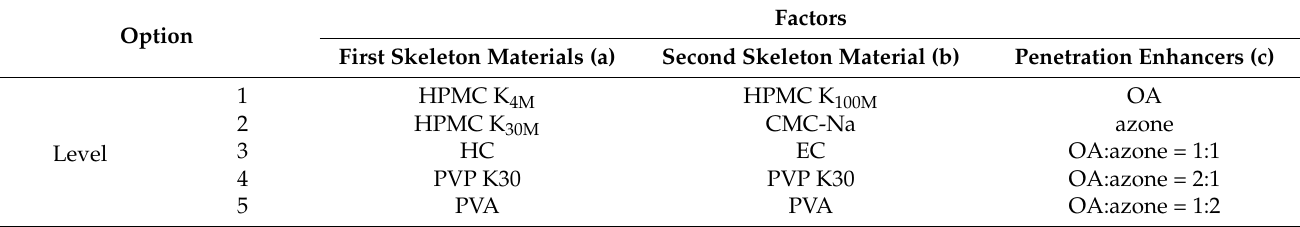
Table 5. Orthogonal test table L 25 (5 5